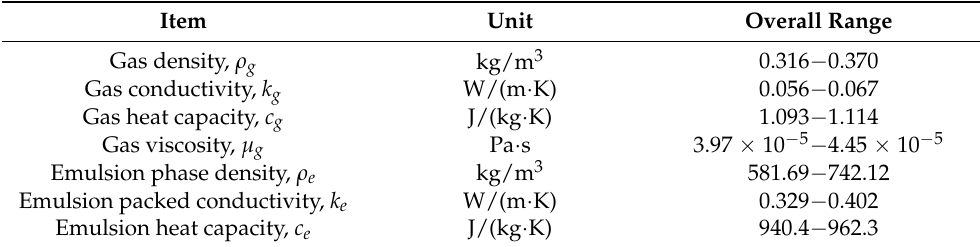
Table 3. Gas and emulsion properties used in this study.